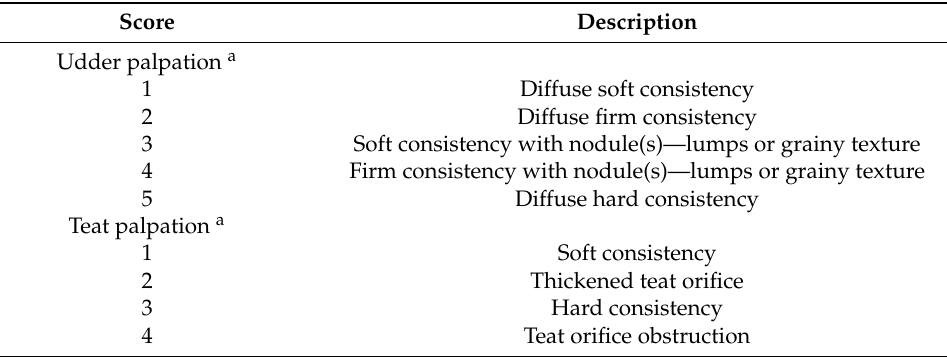
Table 1. Description of the traits and scores used to assess udder health of yearling ewes in late pregnancy and lactation (adapted from [23]). Score